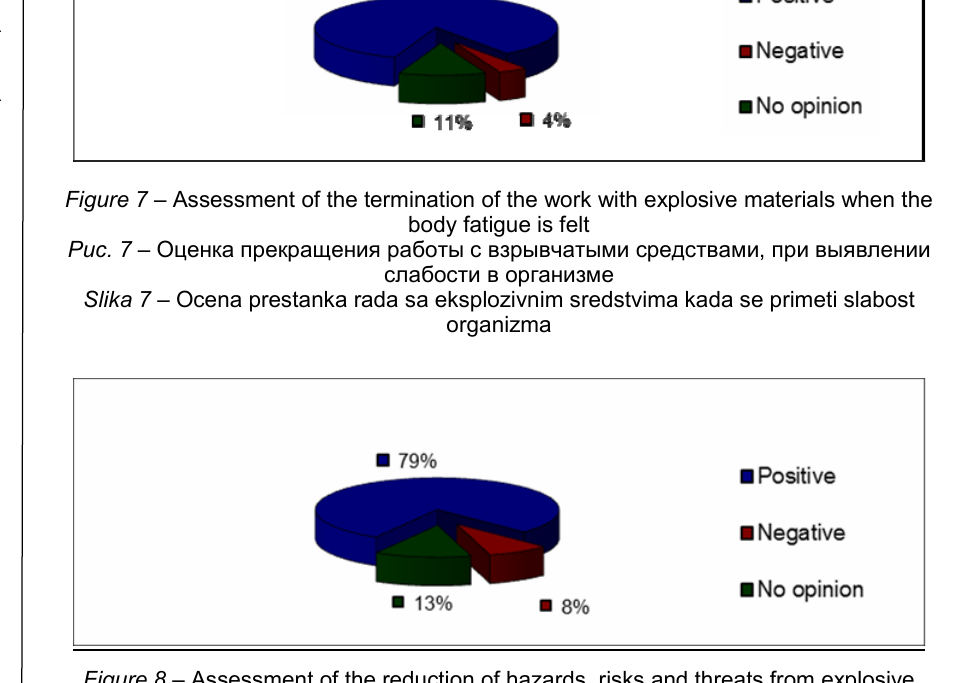
Figure 8 – Assessment of the reduction of hazards, risks and threats from explosive materials by implementing regulative provisions Рис . 8 – Оценка снижения опасности , рисков и угроз от взрыва взрывчатых средств